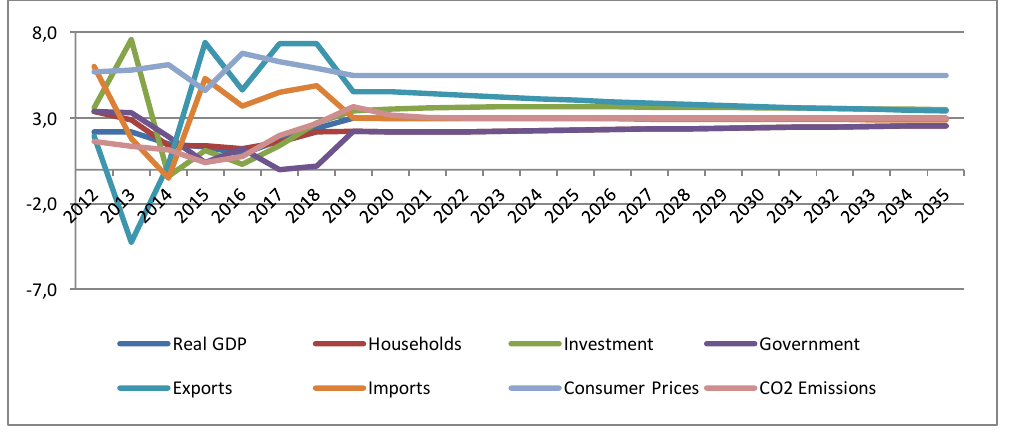
Macroforecasts for 2012 to 2035 (year-on-year percentage